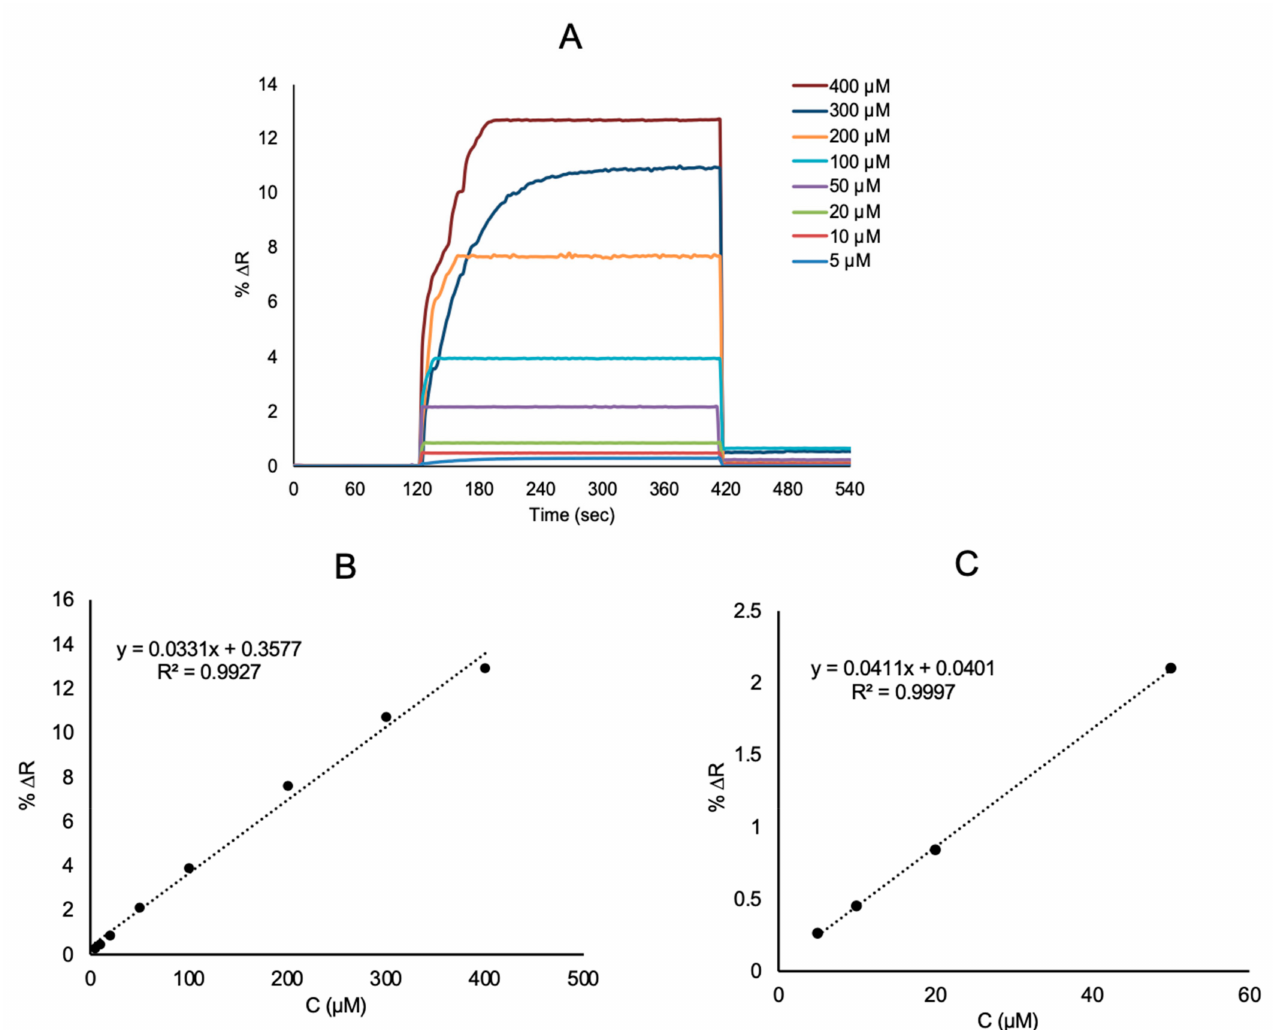
Figure 6. Real-time responses: ( A ) linear regions between 5–400 µ M ( B ) and 5–50 µ M ( C ) of SPR sensors aqueous solutions of L -Phe at different